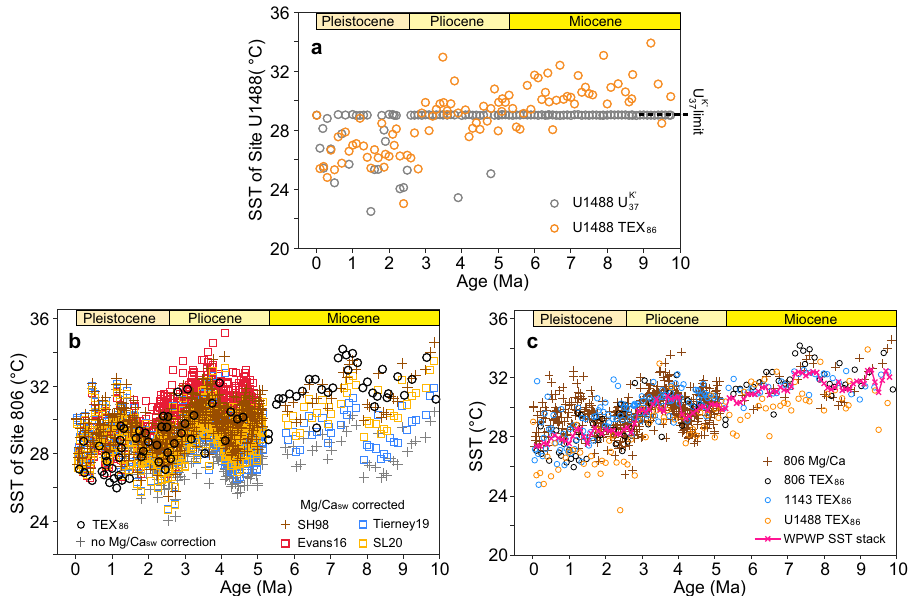
Fig. 2 | Sea surface temperature reconstructions of the Western Paci fi c Warm Pooloverthepast10millionyears.a seasurfacetemperature(SST)ofSiteU1488 derived from TEX 86 (orangecircles) and U K 0 37 (gray circles) proxies. The dashed line represents the maximum allowable temperature (~29°C) of the U K 0 37 proxy. b Site 806 Mg/Ca-SST with and without Mg/Ca sw correction, in comparison with TEX 86 - SST (black circles) of the same site. Brown crosses and red, blue and yellow